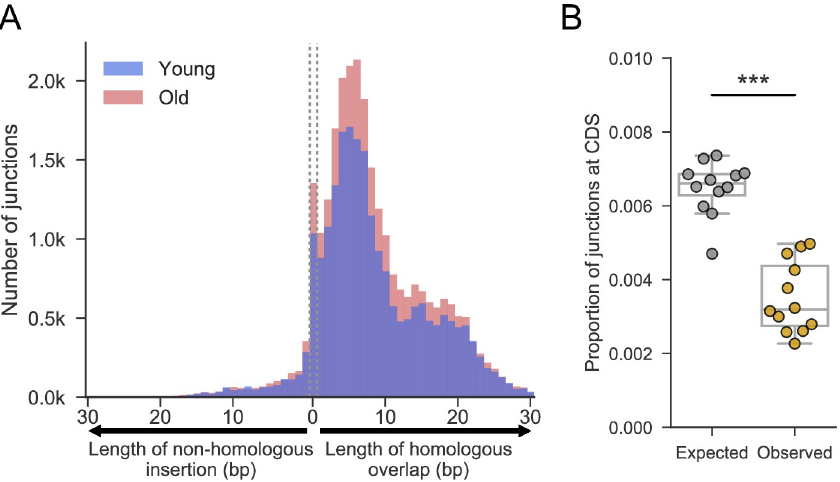
Fig 2. Similar patterns of genome rearrangement in ageing human brain cells as in ageing yeast cells. Analysis was performed on sequence data from putamen samples of neurologically normal Caucasian males [24], six of whom were young (blue; 19, 24, 28, 28, 29 and 30 year old donors) and six of whom were old (red; 67, 71, 78, 83, 85 and 89 year old donors). The 100bp reads from these samples, which were crudely enriched for mtDNA, were re-mapped to the whole human genome and filtered (Materials and Methods). (A) Histograms showing number of junctions with various lengths of microhomology (right of dotted lines), blunt joints (between dotted lines), or non-homologous insertions (left of dotted lines) at breakpoint. Histograms at different ages are overlaid on top of each other, with samples from young donors in blue and older donors in red (as in A). In these sparse data, the difference between young and old brain tissue was marginally significant at best (comparison of number of junctions per mapped read: p Mann-Whitney = 0.23; correlation between sample age and JPMR: p Pearson = 0.17; comparison of average microhomology length: p T-test = 0.05, suggesting slightly shorter mean microhomologies in old tissues, 8.15bp vs 8.28bp). (B) Proportion of junctions expected to fall in coding regions vs proportion that do (based on simulated data; Materials and Methods). One-sided two sample Mann-Whitney U to test whether observed is less than expected (U = 3, p < 0.001). Simulated proportions approached the 1.5% proportion of the genome reported as coding [127] when more junctions were